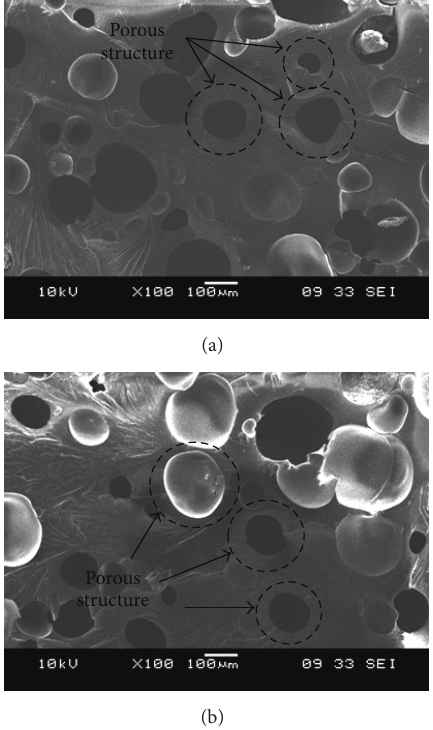
Figure 4: SEM micrograph showing the flexural fracture surface morphology of porous epoxy at 2.0 phr latex in mixing sequences: (a) epoxy, latex, and then hardener (ELH) and (b) epoxy, hardener, and then latex (EHL), respectively.